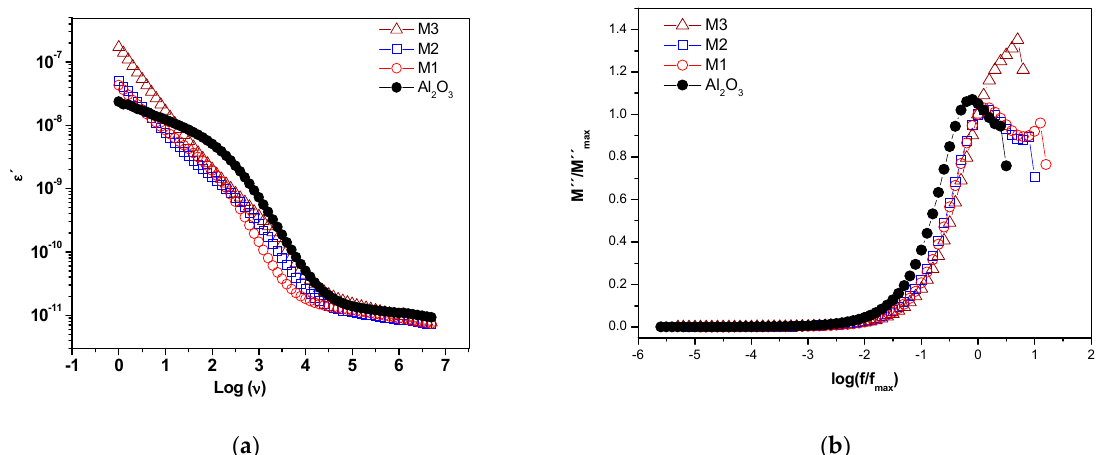
Figure 8. Dielectric spectrum ( a ) real permittivity and ( b ) dielectric module for γ -alumina and supported birnessite materials. For M3, a displacement towards high frequencies occurred at the maximum peak of the dielectric module.